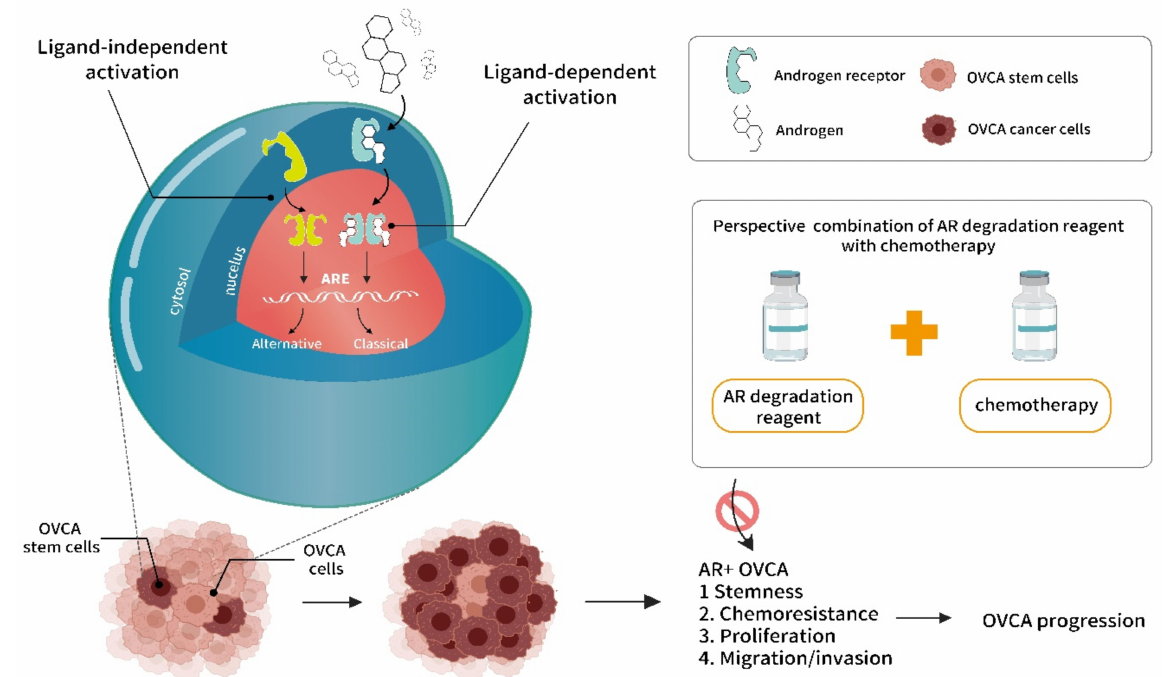
Figure 1. Illustration of androgen/androgen receptor (AR) signaling in ovarian cancer (OVCA) progression, and potential benefit of targeting AR for OVCA therapeutics. The androgen/AR signaling, including ligand dependent vs. independent activation modes that bind on androgen response elements (AREs; including classical and alternative) on promoter region for target gene expressions. The unique androgen/AR signaling occurring at the cancer stem/progenitor cells (CSPCs) of OVCA, which enriches CSPC population. Consequently, lead to enriched cancer stemness, chemoresistance, fast growth of cells, and increase mobility of OVCA. The proposed therapeutics on targeting AR degradation combination with conventional chemotherapy might acquire therapeutic benefit to improve OVCA progression via suppressing AR+ OVCA